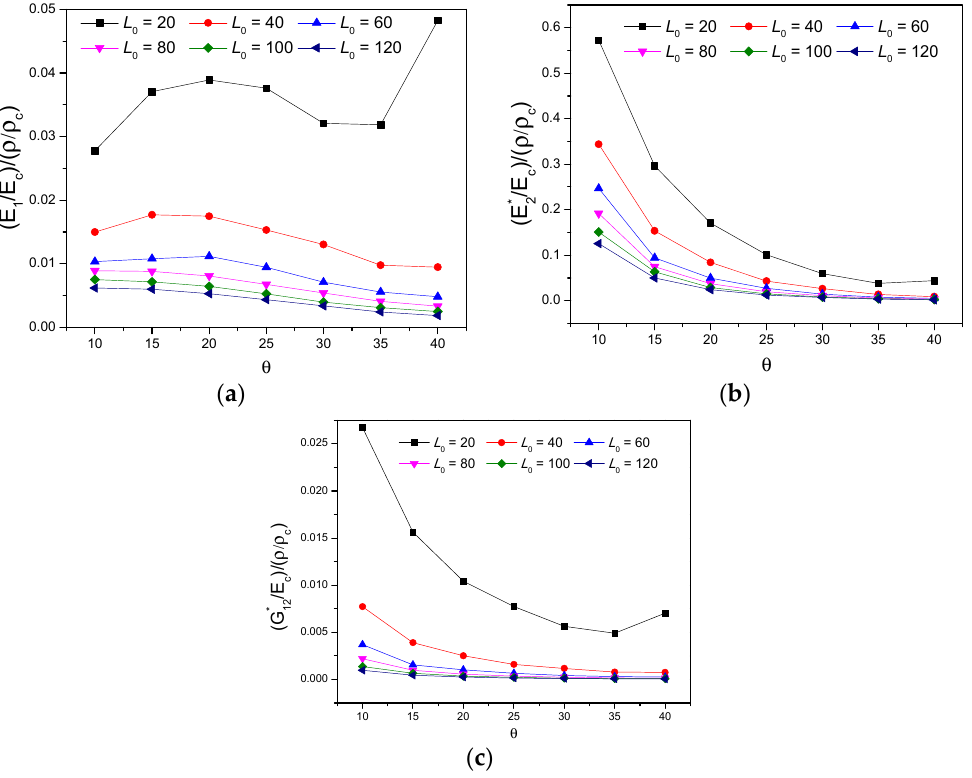
Figure 13. Variations of specific stiffness ( a ) ( E ∗ / E c ) / ( ρ / ρ c ) , ( b ) ( E ∗ 1